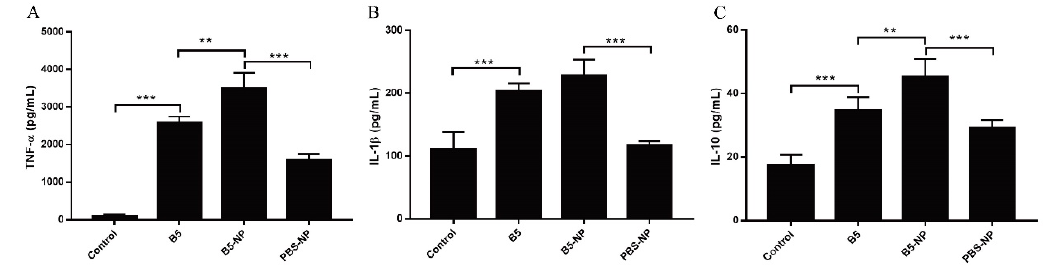
Figure 3. B5 and B5 ‐ NPs induce pro ‐ inflammatory and anti ‐ inflammatory cytokine production in macrophages. ( A – C ) ELISA analysis of TNF ‐α ( A ), IL ‐ 1 β ( B ), and IL ‐ 10 ( C ) production in J774A.1 macrophages stimulated with B5, B5 ‐ NPs, or PBS ‐ NPs for 24 h. B5: BNBD5, B5 ‐ NP: BNBD5 ‐ PLGA NPs, PBS ‐ NP: PBS ‐ PLGA NPs. All data are shown in vitro representing the mean ± SD of three independent experiments (** p < 0.01; *** p < 0.001).